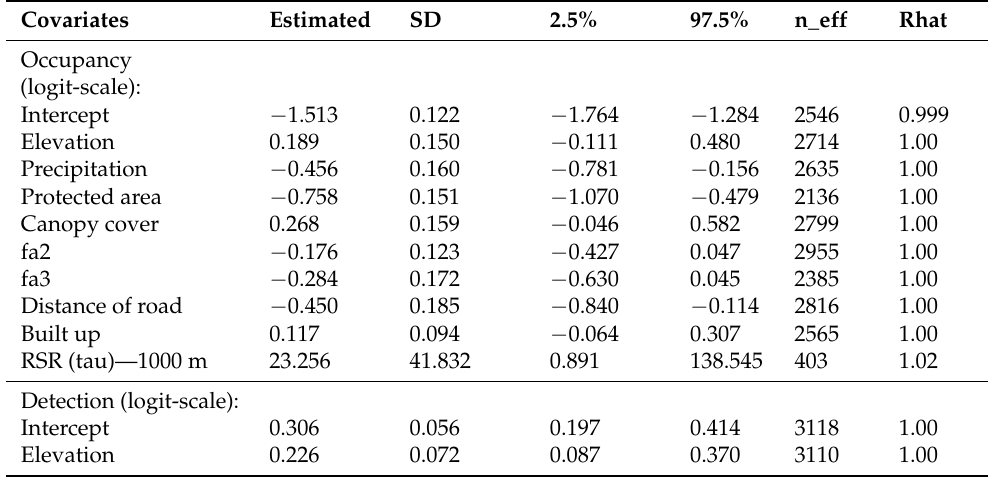
Table A4. Output summary from the best spatial occupancy model ( ψ (intercept + elevation + precipitation + protected area + canopy cover + fa2 + fa3 + distance of road + built up + RSR-1000); ρ (intercept + elevation)) of chicken ( Gallus gallus domesticus ) in Puerto Rico. Note: fa2 = proportion of forest cover aged between 32 and 54 years; fa3 = proportion of forest cover aged 55 years and older. RSR = restricted spatial regression (threshold = 1000 m). Runtime: 2.788 h.